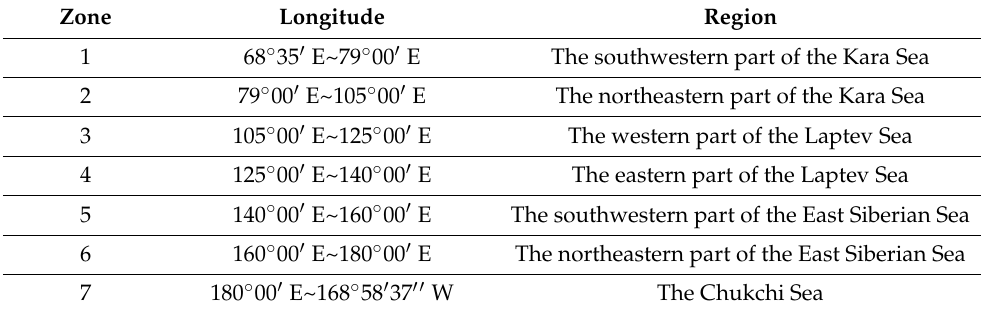
Table 8. Icebreaker escorting zones in the